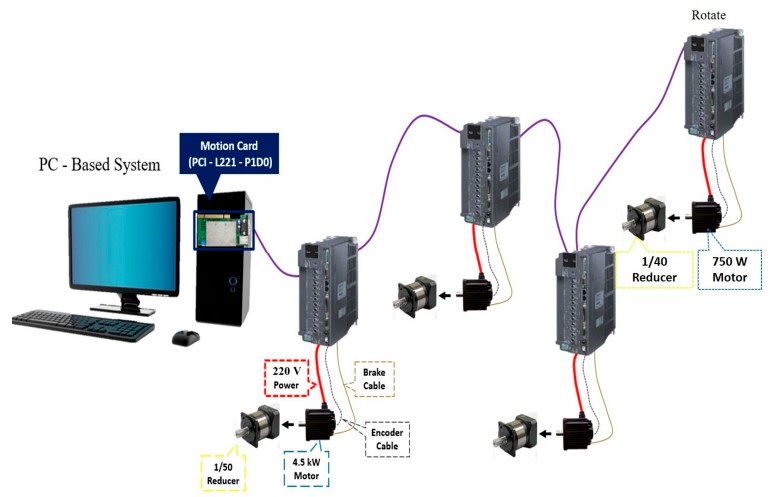
Figure 29. The communication method of